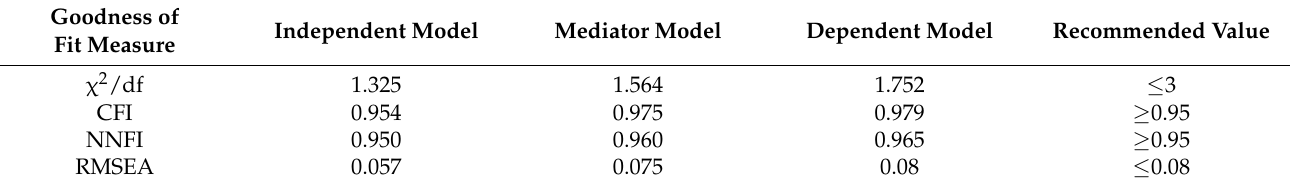
Table 2. Measurement model goodness of fit statistics.